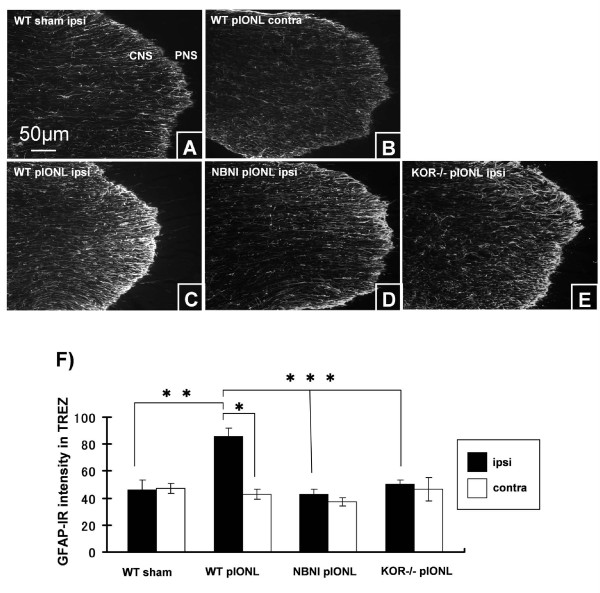
GFAP immunoreactivity in the TREZ at day 8 after pIONL. (A), GFAP-IR in sham operated WT mice. (B, C), pIONL induced slight increase in the intensity of GFAP staining in the ipsilateral TREZ of WT mice but not the contralateral side. (D, E), KOR-/- mice or mice pre-treated with norBNI did not show significant upregulation of GFAP immunoreactivity in the ipsilateral TREZ, and this was the same intensity as in the contralateral TREZ of WT pIONL mice (B) or WT sham operated mice(A). (F), Mean ± SEM pixel intensity of GFAP immunoreactivity in TREZ at day 8 after pIONL. (*p < 0.001) Scale bars: A-E, 50 μm